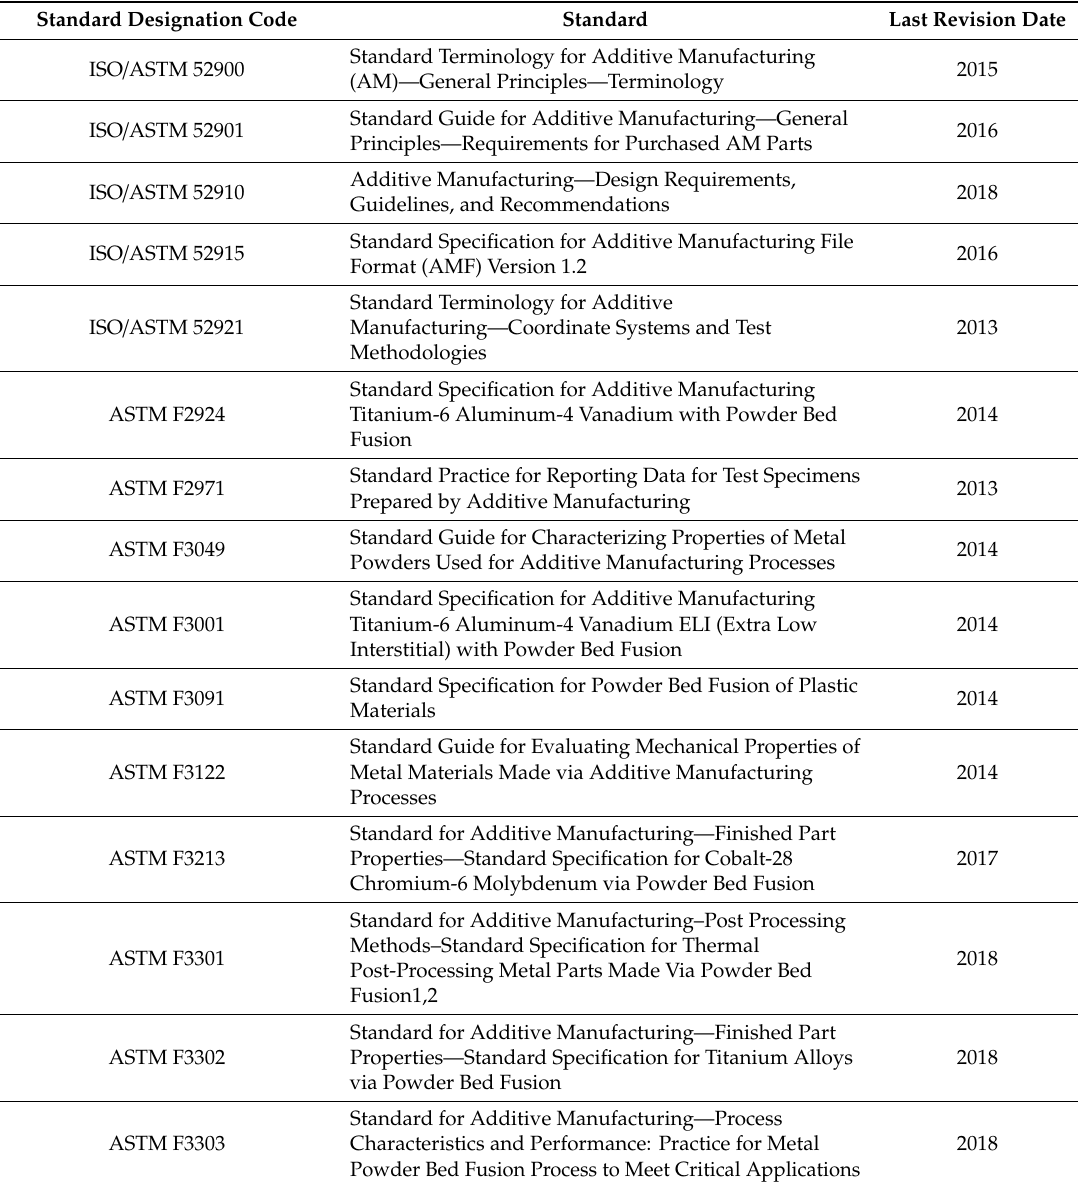
Table 1. Existing ISO / ASTM active standards for additive manufacturing relevant to patient-specific implants and surgical